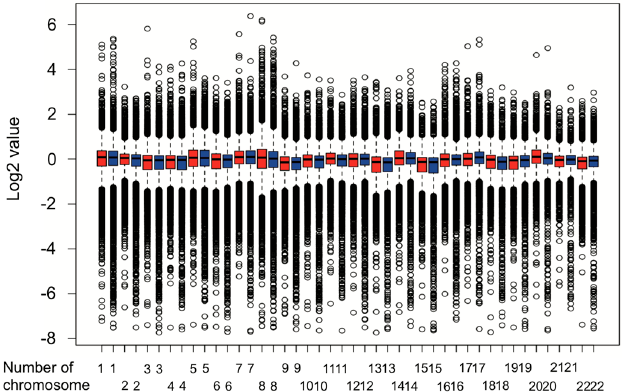
Figure 2. Copy number variation analysis in two subtypes. Red box represents low-risk subtype, and blue box represents high-risk subtype.